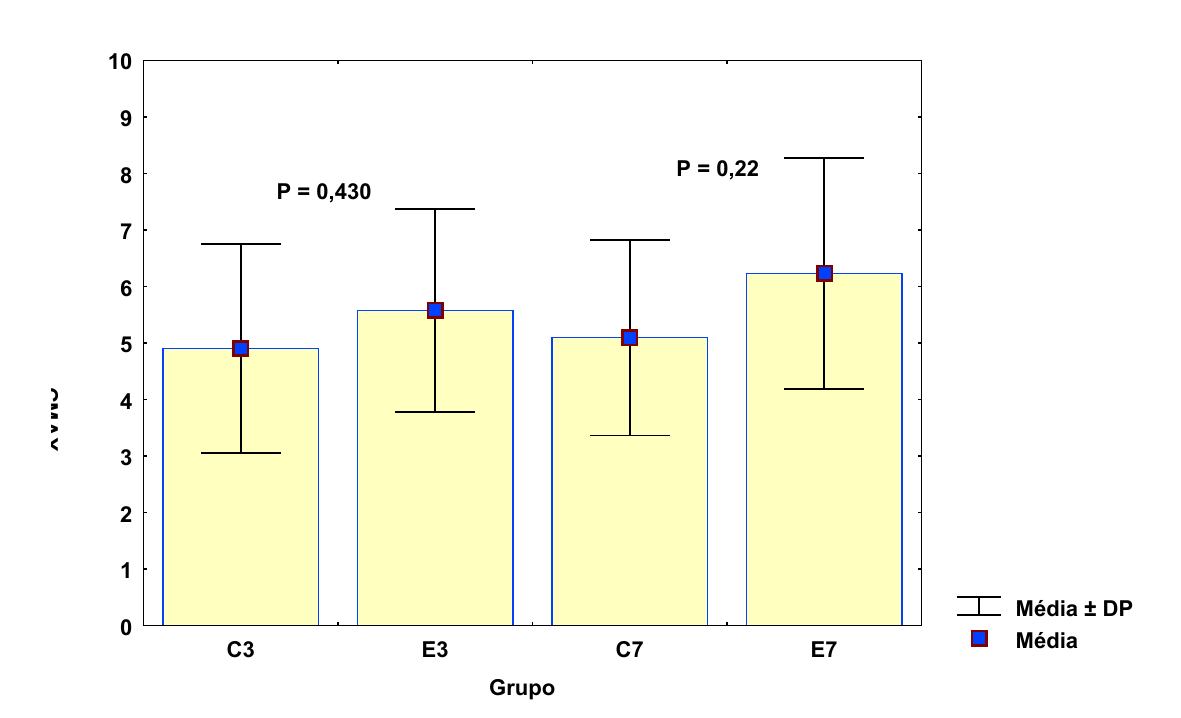
FIGURA 5 – Variável Cmax com média e desvio padrão dos grupos controle e experimento. Legenda: C3 = GC3D, E3 = GE3D,